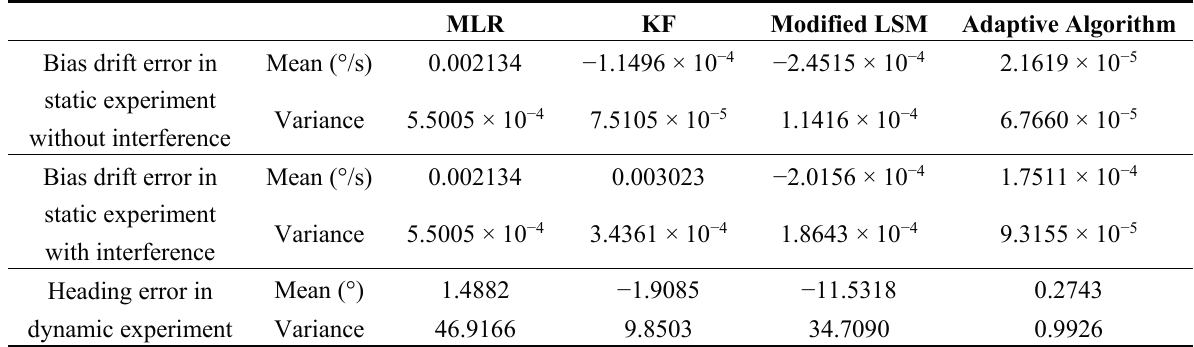
Table 2. Comparison of compensation results of the four